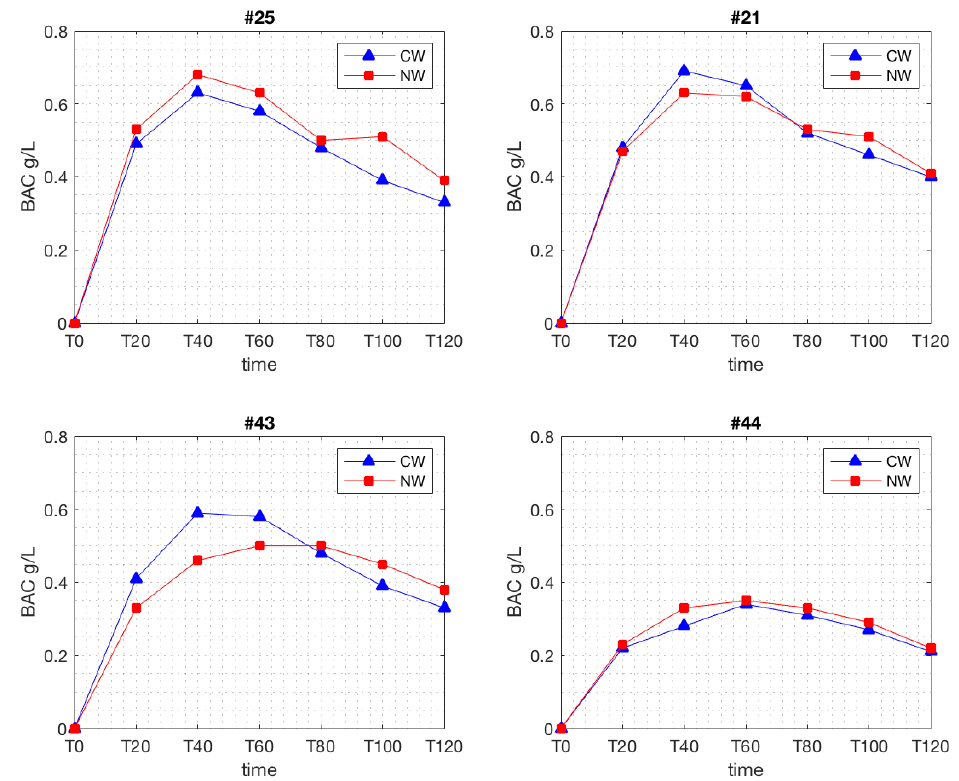
Figure 1. Examples of blood alcohol concentration (BAC) levels measured every 20 min after the Figure 1. Randomly selected examples of blood alcohol concentration (BAC) levels measured every 20 ingestion of the conventional wine (CW) and of the natural wine (NW) (g/L), in subjects #21, #25, #43, min after the ingestion of the conventional wine (CW) and of the natural wine (NW) (g / L), in subjects and #44. #21, #25, #43, and